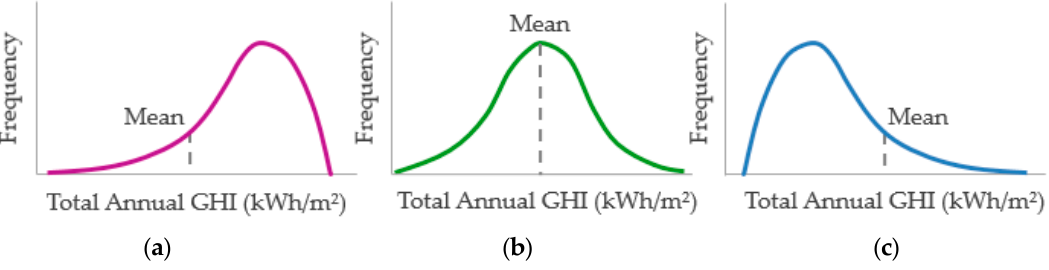
Figure 5. Skew-normal distribution [19]: ( a ) Negatively skewed distribution; ( b ) Normal skewed distribution; and ( c ) Positively skewed distribution.